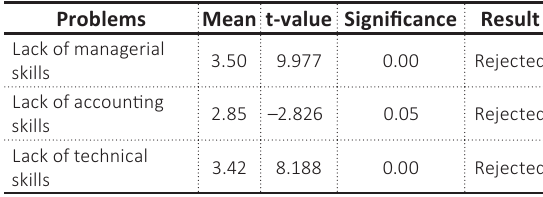
Table 11. Knowledge-related challenges